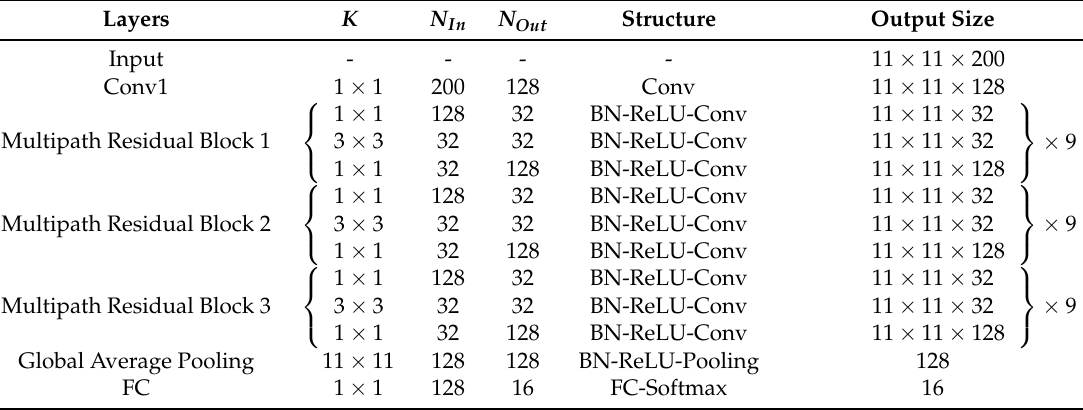
Figure 4. Framework of multipath ResNet (MPRN) for hyperspectral image (HSI) classification. Table 1. The detailed network architecture of MPRN for the Indian Pines data set.